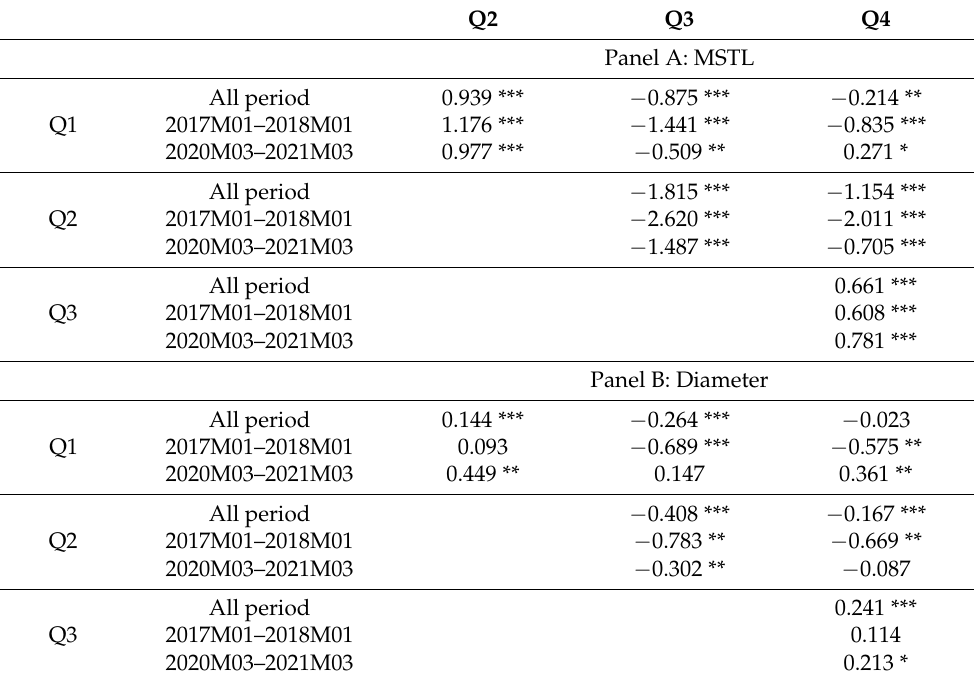
Table 1. ETFs Network measures by ESG quartiles. Q2 Q3 Q4 Panel A: MSTL All